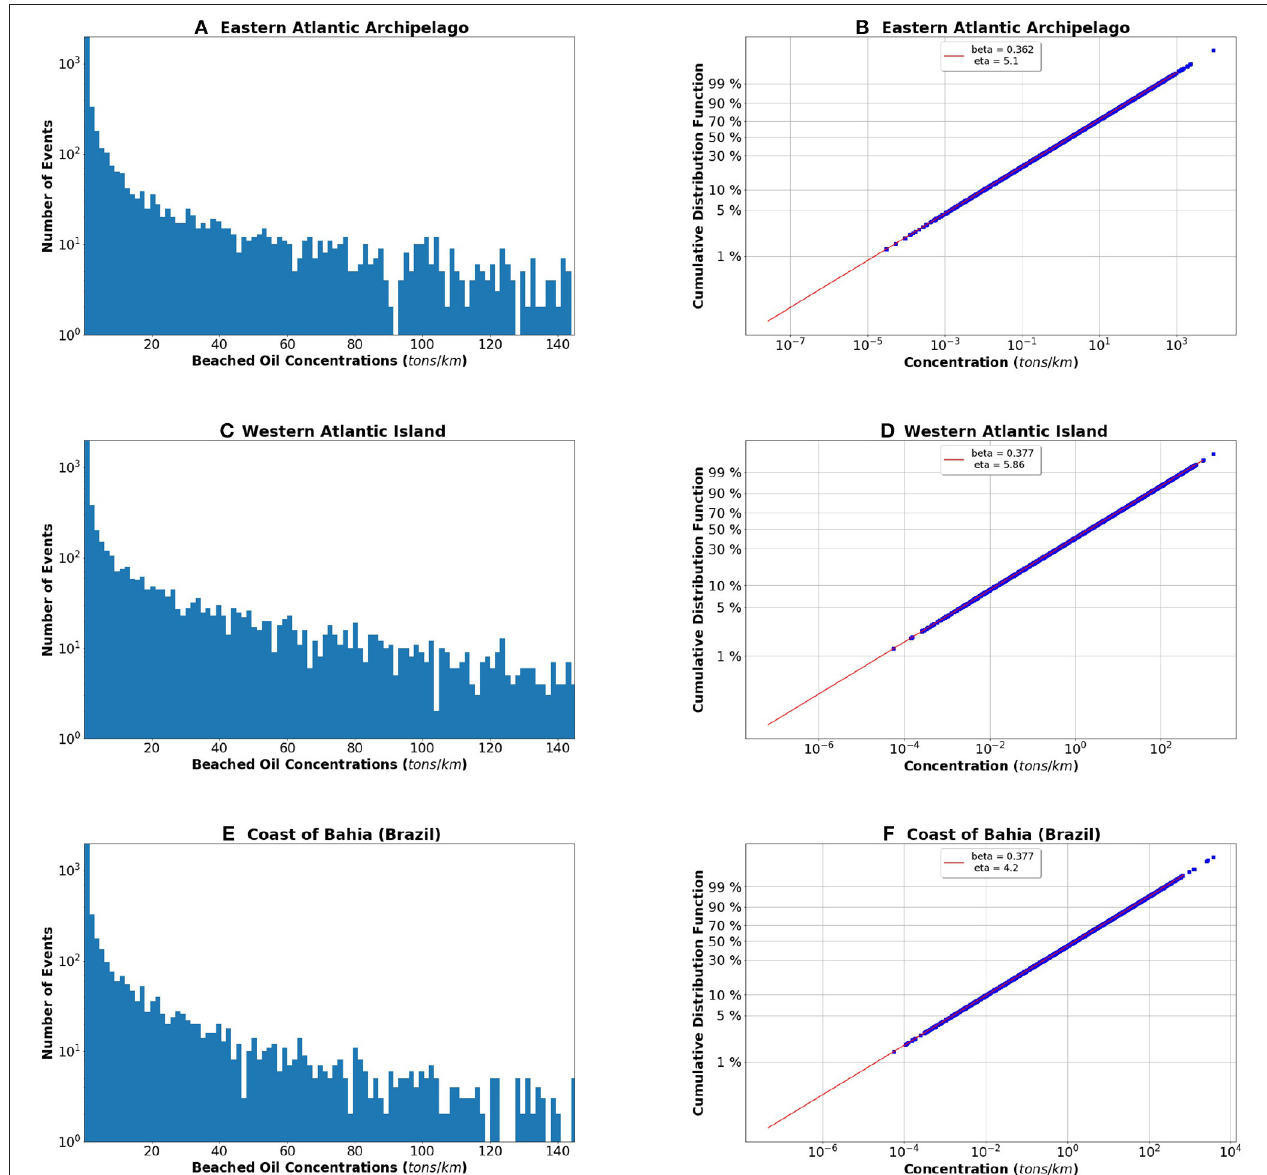
FIGURE 4 | (A,C,E) The histogram for each of the three study areas, the Eastern Atlantic Archipelago, the Western Atlantic Island, and the Bahia coasts respectively, displayed with a logarithmic scale. (B,D,F) The Weibull plot with the cumulative distribution function F ( x ) abscissa, both displayed on a logarithmic